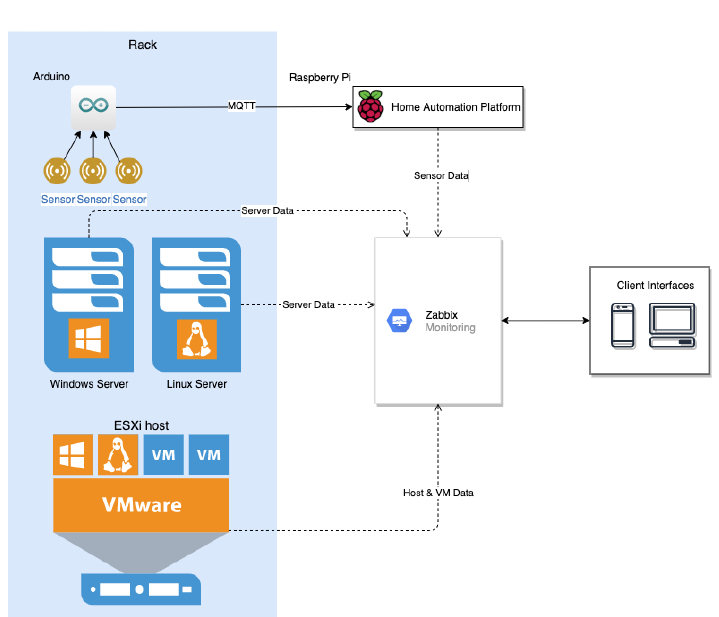
Figure 1. Global Architecture Diagram showing how all components communicate with each